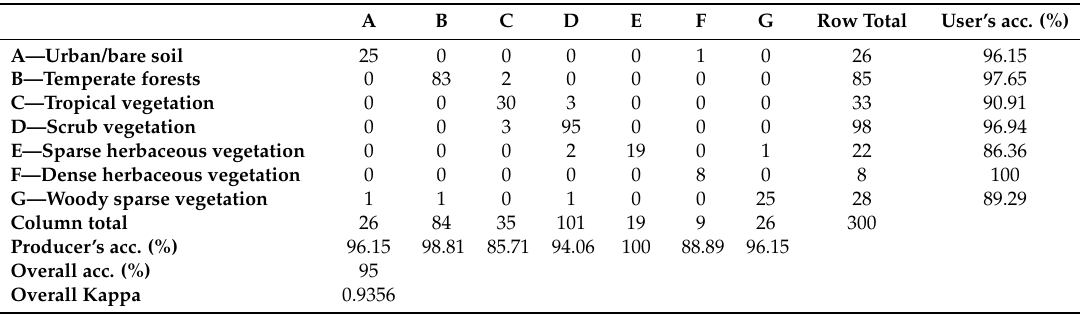
Table 7. Error matrix for land use-cover, 2005. Natural Protected Area Altas Cumbres. Victoria, Tamaulipas, Mexico.